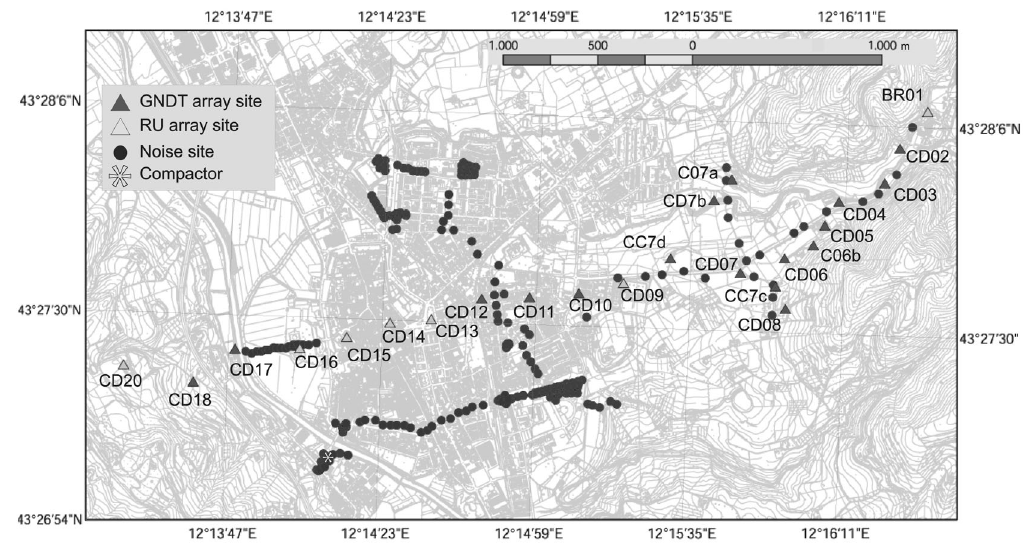
Fig. 2b. Station locations in the study area. Triangles show the sites of the array stations: the GNDT experi- ment ones are in dark gray while the Regione Umbria (RU) ones, re-occupied during the GNDT experiment, are in light gray. Dots show noise measurements sites. Star located the compactor device described in the